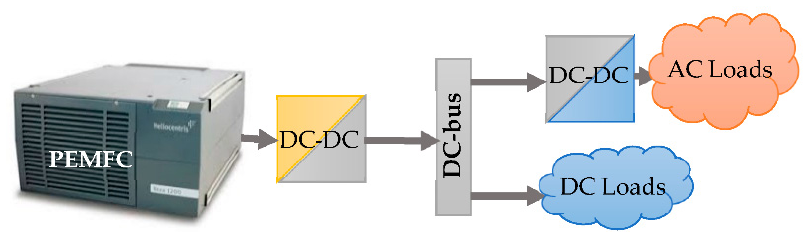
Figure 1. DC-bus voltage for a PEMFC.